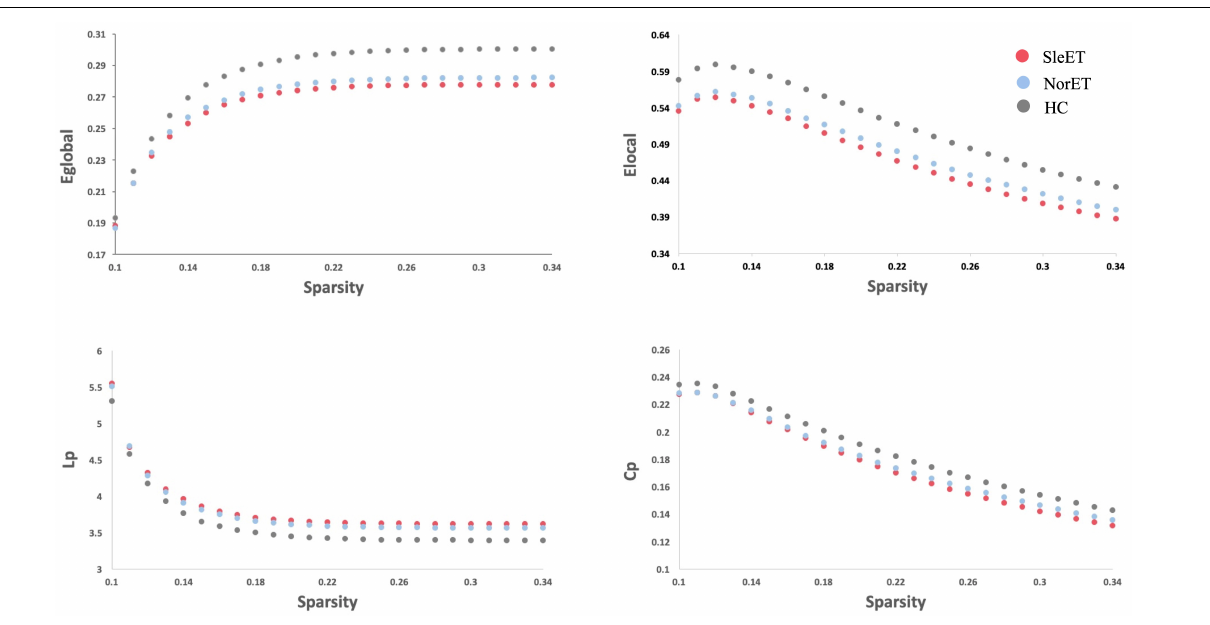
FIGURE 1 | Altered global topologic properties of the brain functional connectome in SleET patients, NorET patients and healthy controls (non-parametric permutation test, p < 0.05). The global efficiency (Eglobal; p = 0.0015), local efficiency (Elocal; p = 0.0067), clustering coefficient (Cp; p = 0.0491) and characteristic path length (Lp; p = 0.0005) significantly differ among the three groups. Post-hoc tests revealed that SleET patients showed significant differences in Eglobal ( p = 0.0003), Elocal ( p = 0.001), Cp ( p = 0.0131) and Lp ( p = 0.0001). The figure shows Eglobal, Elocal, Cp and Lp of the functional networks of SleET patients, NorET patients and HC at each cost threshold (0.1–0.34, step = 0.01). SleET Essential tremor with poor sleep quality; NorET, Essential tremor with normal sleep quality; HC, Healthy controls; p < 0.05 with FDR